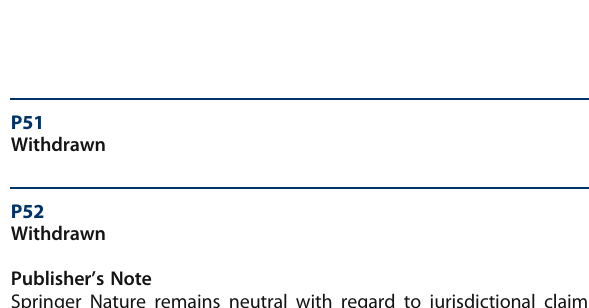
Fig. 2 (abstract P50). Questionnaire results pre/post